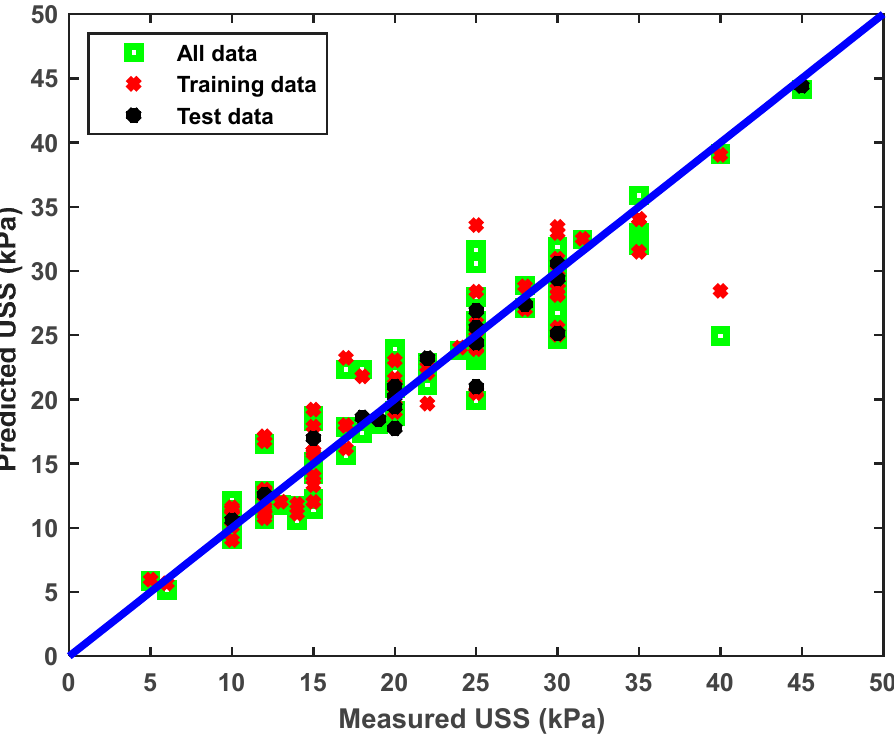
Figure 6. Comparison results of the trained model, predicted versus actual output data of vane-tested USS. The straight line denotes to line of equality .